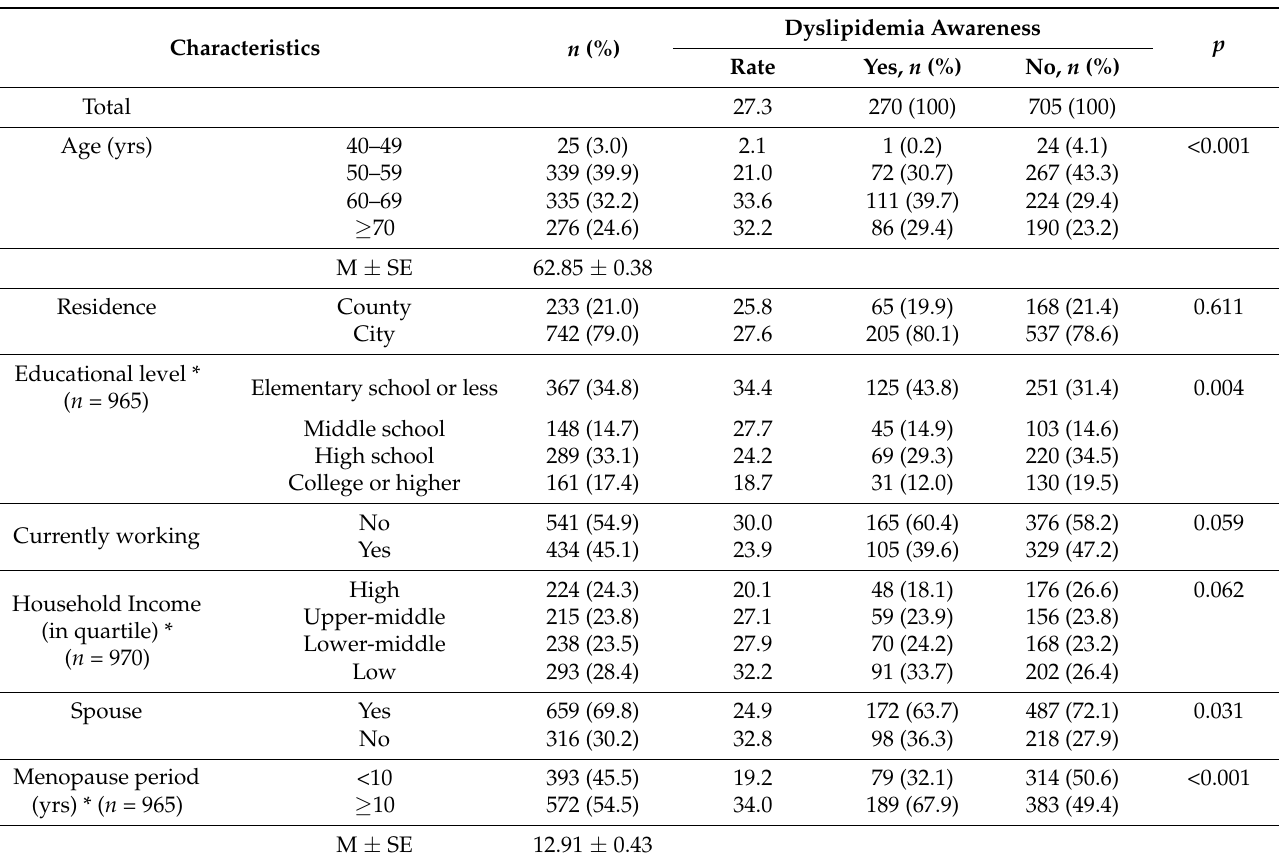
Table 1. Demographic characteristics and dyslipidemia awareness level in menopausal women ( n =